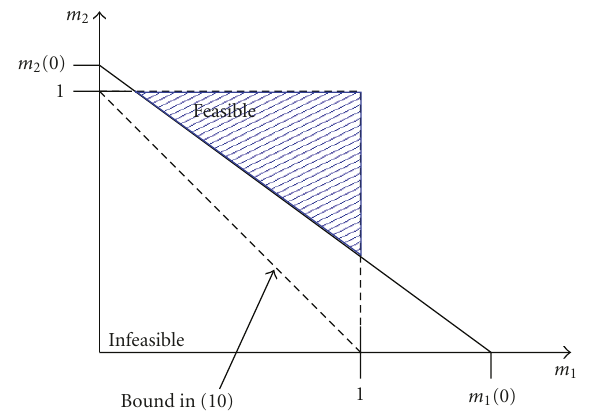
Figure 3: Guaranteed MSE region with linear precoding and full